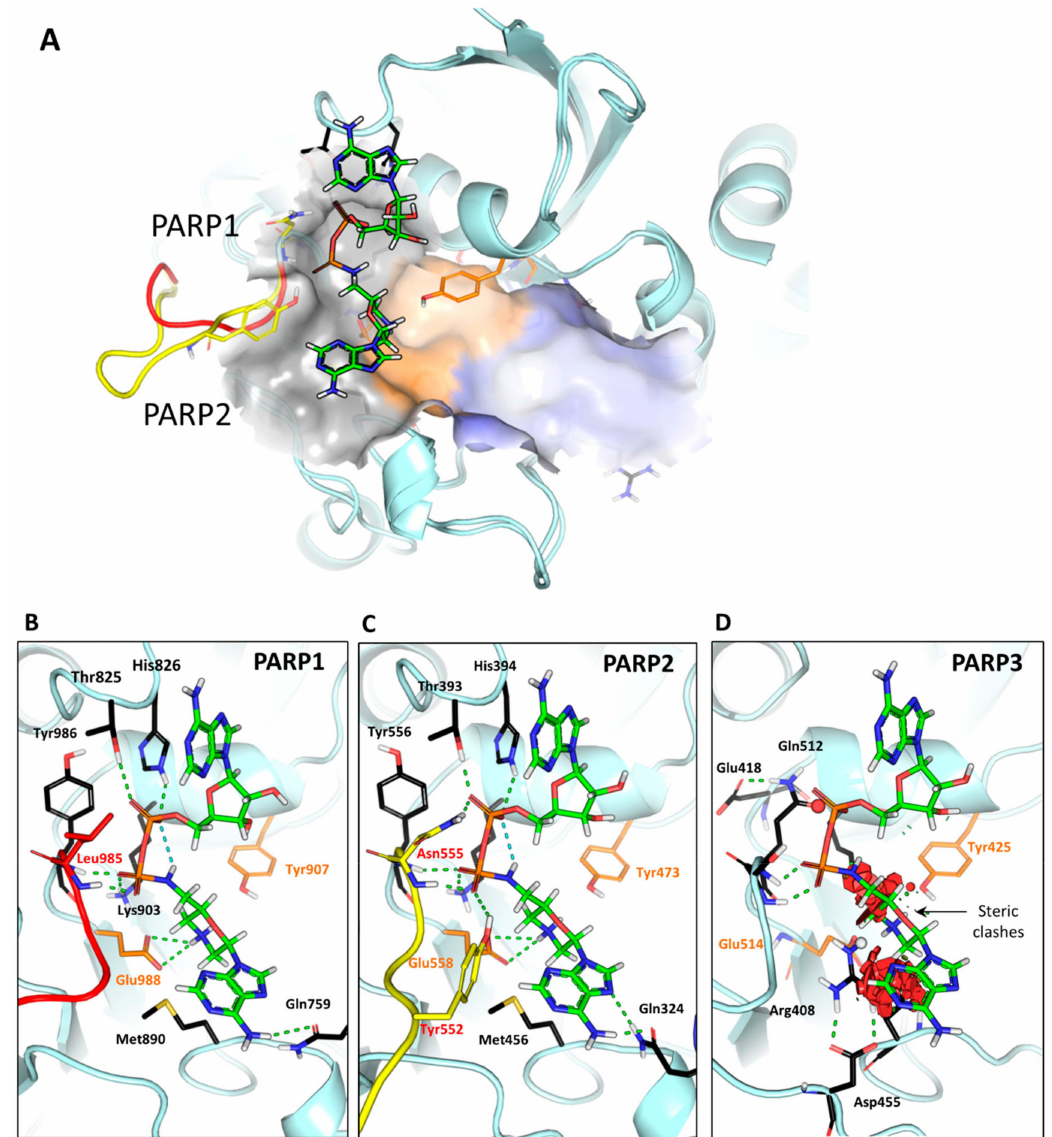
Figure 8. Predicted binding pose of 10A with the acceptor binding site of the PARP-1 / 2 catalytic domain. ( A ) The structural alignment of PARP-1 and PARP-2. Variable loops are indicated in red and yellow colors for PARP-1 and PARP-2, respectively. Detailed view of 10A interaction with PARP-1 ( B ) and PARP-2 ( C ) is shown. ( D ) PARP-3 acceptor binding site with superimposed binding pose of 10A from PARP-2 / 10A complex . Steric clashes are shown with red disks. Unsatisfied hydrogen bond donor and acceptor atoms of the PARP-3 acceptor binding site hindered by ligand are shown as spheres. Hydrogen bonds are depicted as dashed lines. HD domain is not shown for